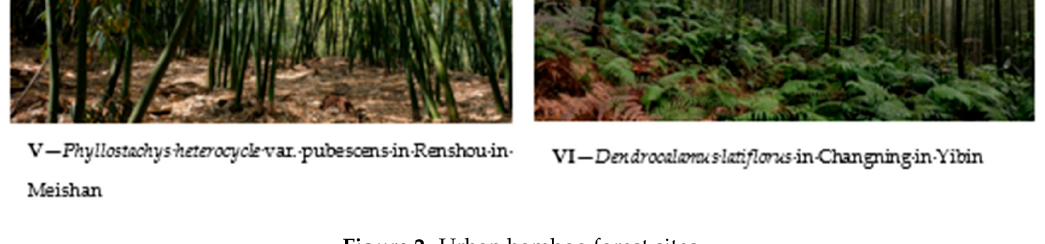
Figure 2. Urban bamboo forest sites.